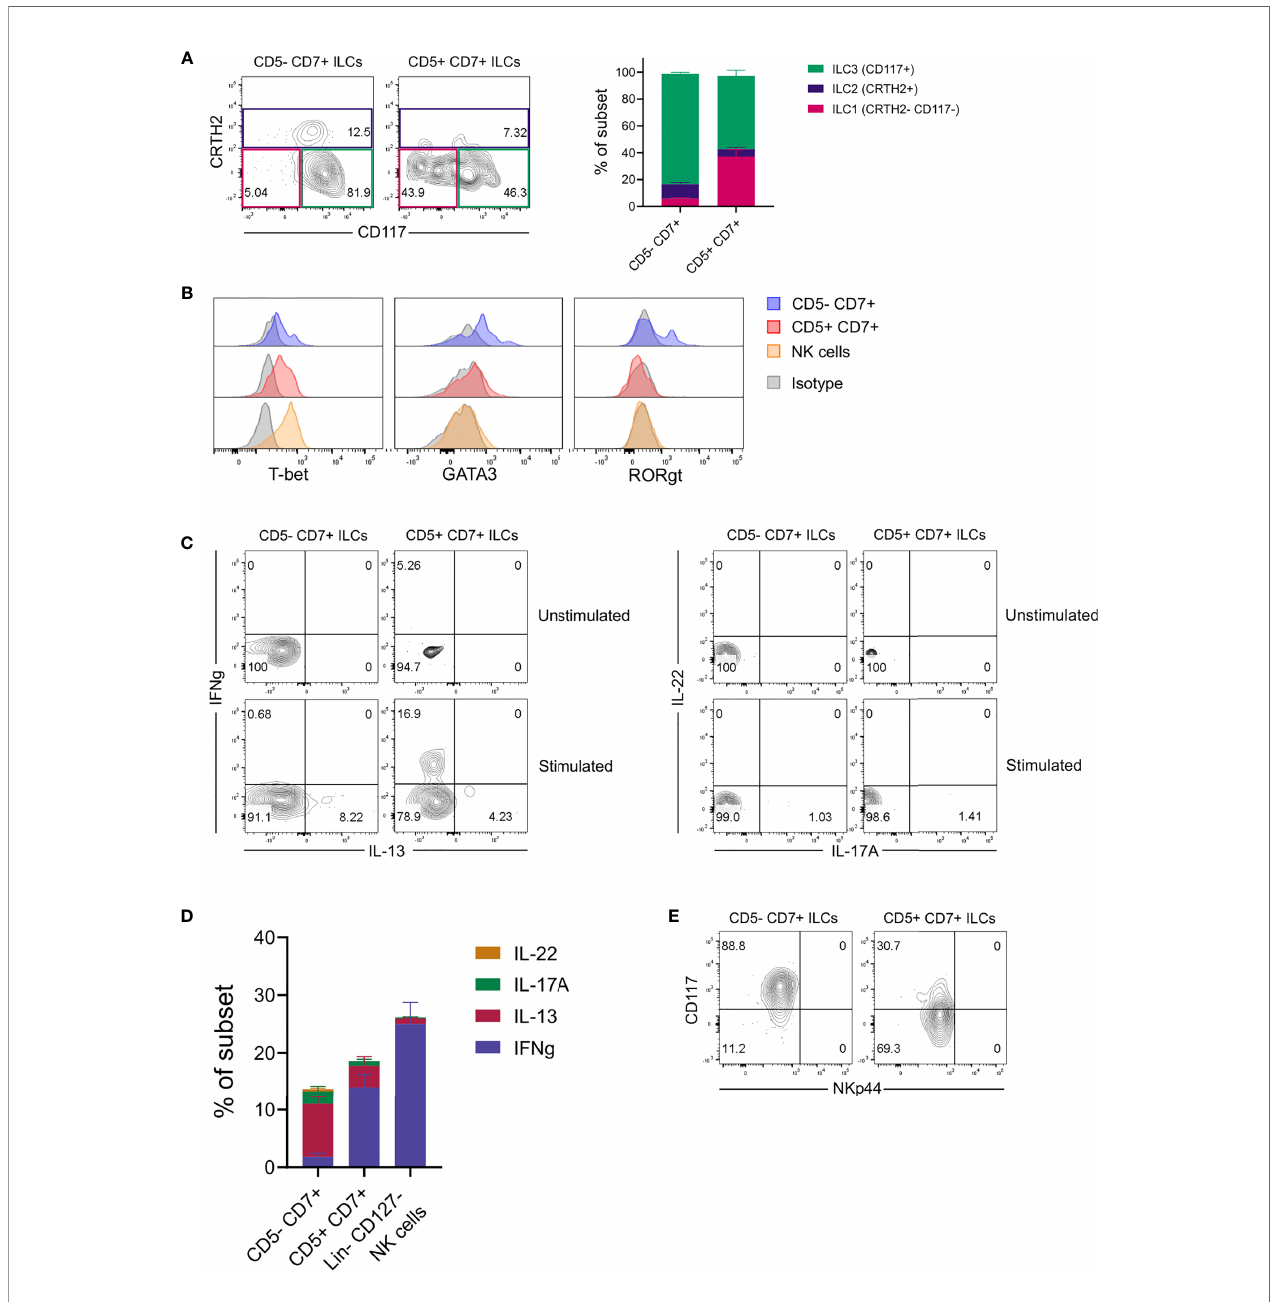
FIGURE 2 | CD5 + ILCs in the lung contain both mature ILC1s and functionally immature ILCs. (A) Frequencies of ILC1s (CD117 - CRTH2 - ), ILC2s (CRTH2 + ), and ILC3s (CD117 + CRTH2 - ) among ILC subsets based on expression of CD5 and CD7 in the lung of HSPC-engrafted MISTRG mice (n = 7). ILCs were gated as human CD45 + Lin - CD3 - TCR ab - CD94 - CD127 + cells as in Figure 1B and then as CD5 - CD7 + or CD5 - CD7 + ILCs as in Figure 1C . (B) Intracellular expression of signature transcription factors (T-BET, GATA3, ROR g t) in human CD5 - CD7 + ILCs, CD5 + CD7 + ILCs, and NK cells isolated from the lung of HSPC-engrafted MISTRG mice. ILCs were gated as human CD45 + Lin - CD3 - TCR ab - CD127 + cells and NK cells were gated as human CD45 + Lin - CD3 - TCR ab - CD127 - CD56 + cells. Matched isotype antibodies were used as controls. (C) Intracellular IFN g and IL-13 as well as IL-17A and IL-22 production by human CD5 - CD7 + and CD5 - CD7 + lung ILCs from HSPC-engrafted MISTRG mice. Cells were stimulated with PMA/ionomycin or left unstimulated. (D) Frequencies of effector cytokine-producing cells in each CD5/CD7-expressing ILC subset and NK cells following PMA/ionomycin stimulation (n = 5). NK cells were gated as human CD45 + Lin - CD3 - TCR ab - CD127 - cells. (E) NKp44 surface expression on human CD5 - CD7 + ILCs and CD5 + CD7 + ILC in the lung of HSPC-engrafted MISTRG mice. ILCs were gated as human CD45 + Lin - CD3 - TCR ab - CD94 - CD127 + cells as in Figure 1B . Data represent mean ± SEM and are representative of at least two independent